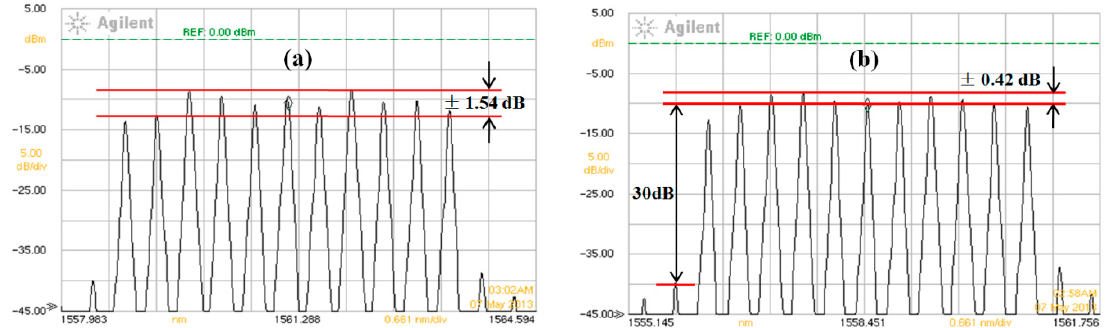
Figure 6. The output spectrum of oscillations at P = 113 mW and R 1 = 50/50, ( a ) coarse adjustment, ( b ) fine adjustment.